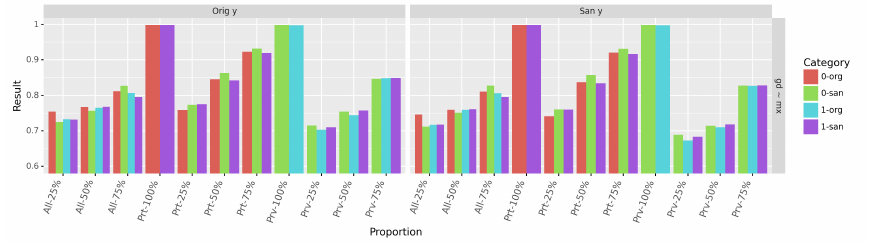
Figure 10. Accuracy (mean) of Gradient Boosting (GB) trained to predict the sensitive attribute on Adult (mixed dataset). The accuracies on original data are both around 85% for the protected and the privileged group regardless of the decision type. On the sanitized data, it is around 68% for both groups using San y and around 71% using Orig y . Note that the standard deviation is less than